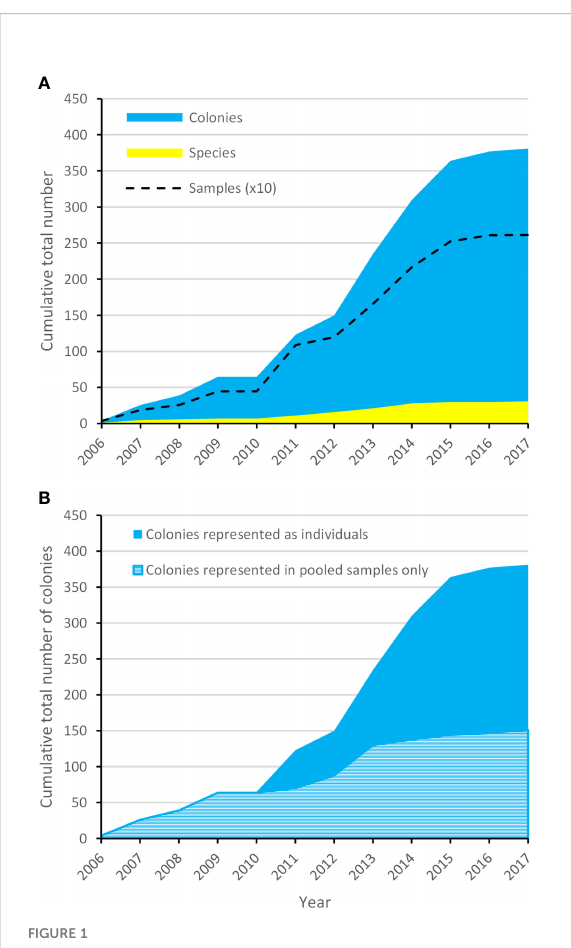
FIGURE 1 Growth (A) and diversi fi cation of sampling strategy (B) of Taronga ’ s CryoDiversity Bank coral collection between 2011 and 2022.